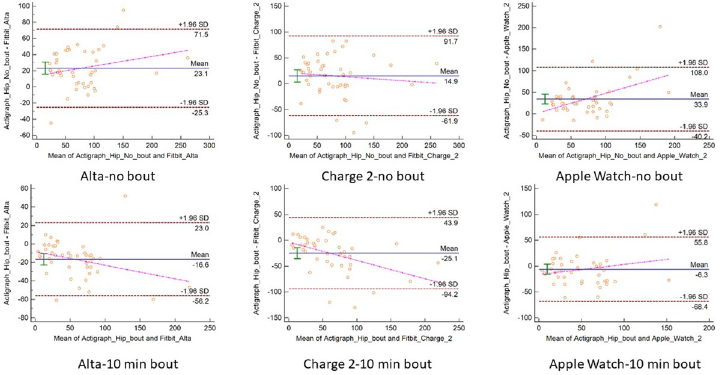
Fig 3. Bland-Altman plots comparing moderate-to-vigorous physical activity between ActiGraph and three consumer activity monitors with- and without bout criterion.